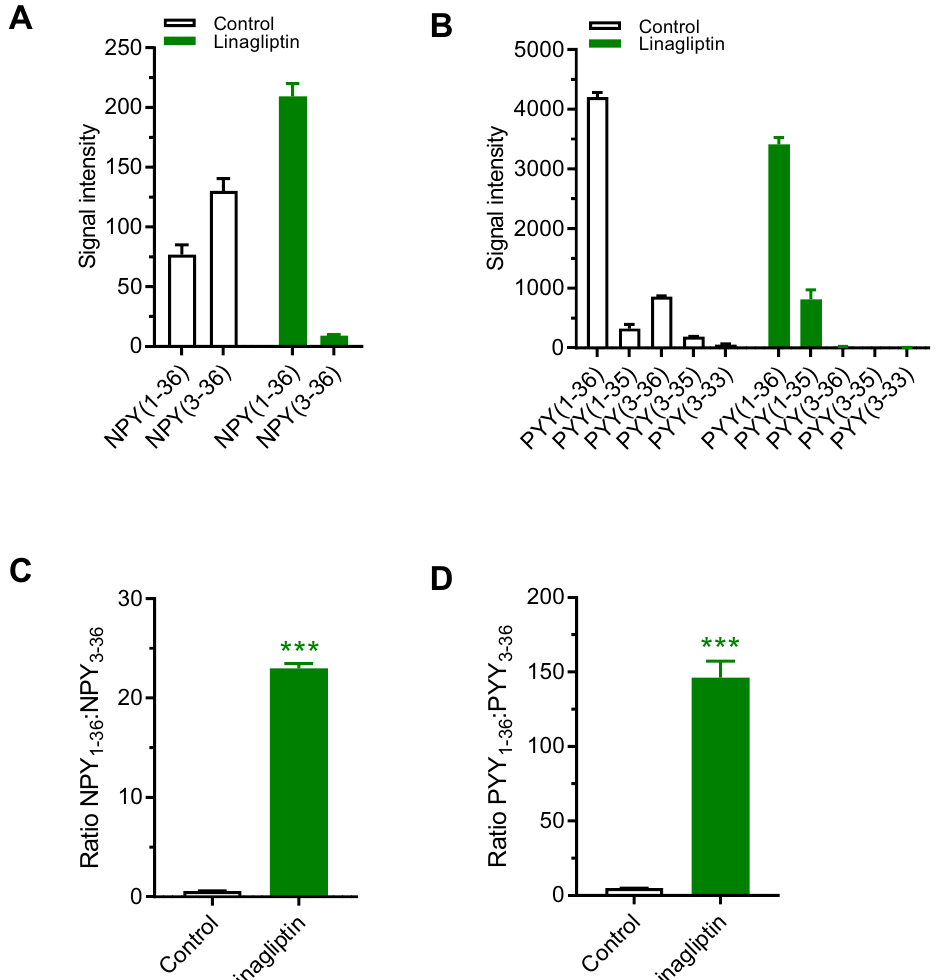
Figure 3. Linagliptin prevents conversion of full-length NPY and PYY to NPY 3–36 and PYY 3–36 in human plasma samples. Synthetic NPY 1–36 and PYY 1–36 was evaluated as DPP-IV substrates with or without addition of linagliptin [1 µM, incubation times: 8 h (NPY), 18 h (PYY)]. (A) Concentrations of full-length NPY 1–36 and NPY 3–36 . (B) Concentrations of full-length PYY 1–36 and PYY 3–36 . (C) NPY 1–36 :NPY 3–36 ratio, (D) PYY 1–36 :PYY 3–36 ratio. ***p < 0.001 vs. vehicle